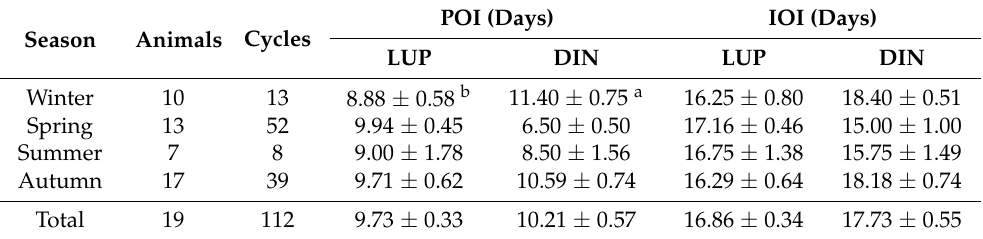
Table 2. Prostaglandin–ovulation interval (POI) and interovulatory interval (IOI) in cycles of jennies treated with luprostiol (LUP) or dinoprost tromethamine (DIN), depending on the season. POI (Days) Season Animals Cycles